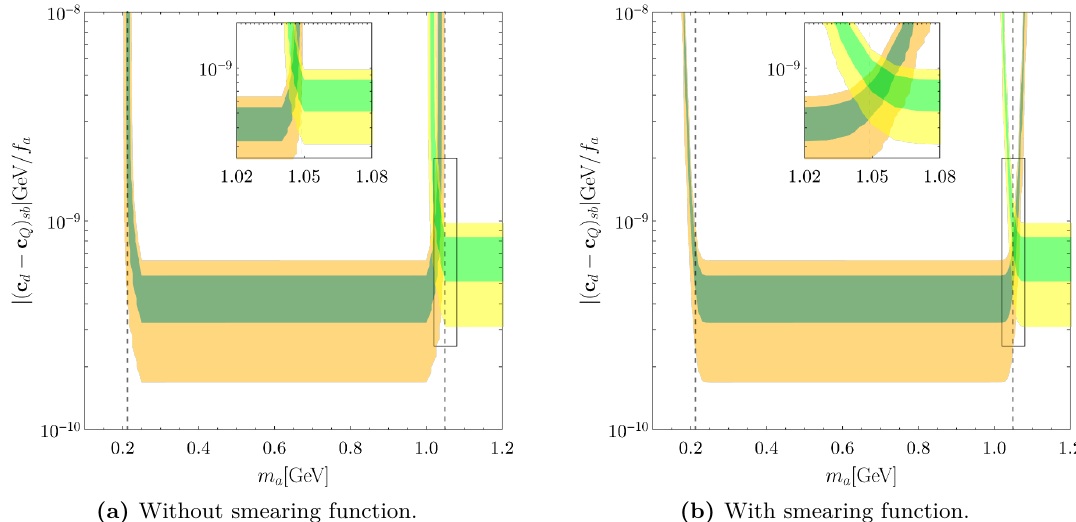
Figure 11. Golden ALP mass. Impact of the smearing function in (a selected region of) the parameter space m vs. | ( c ) for the R anomaly. On the left (right) the case without a d − c Q sb | /f a K ∗ (with) the effect of the smearing function. The benchmark point for the ALP-lepton couplings is ( | ( c ) ( c ) ) = (10 − 1 , 10 − 5 ) GeV − 1 . In green (yellow) the 1 σ (2 σ ) allowed e − c L ee | /f a , | e − c L µµ | /f a region for the low and central energy-bin window, with the darker colours corresponding to the low